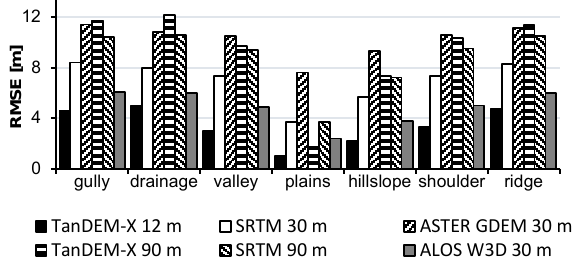
Figure 4. Calculated RMSE of elevation according to TPI classes classified with 12 m TanDEM-X.